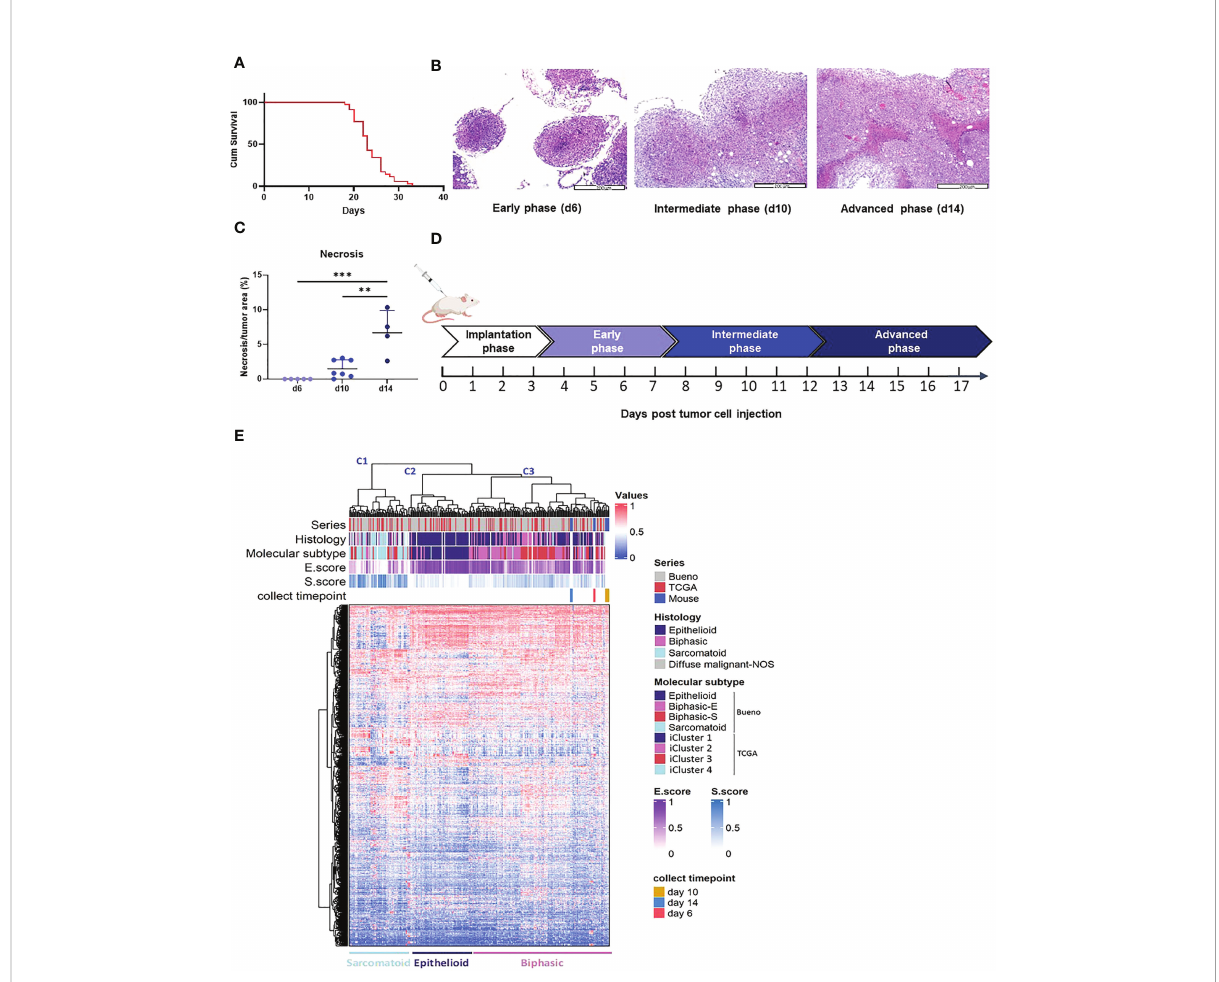
FIGURE 1 AB12 tumors characterization. (A) Kaplan-Meier survival curve of mice injected with AB12 cells. n=28. Cum: cumulative. (B) Histological features of early, intermediate and advanced phase AB12 tumors. Representative hematoxylin and eosin staining of tumors. Original magni fi cation X10. (C) Evaluation of the necrosis area in AB12 tumors. The percentage of necrotic area out of the entire tumor area in d6, d10 and d14 tumors is shown. Values of the post hoc Tukey test are indicated at the top of the dot plots. **: p ≤ 0.01; ***: p ≤ 0.001. (D) Schematic axis of tumor development. (E) Integration based on transcriptomic data of AB12 tumors in hMPM tumors. Unsupervised clustering of d6, d10 and d14 AB12 tumors with 295 hMPM tumor samples was performed based on transcriptomic data obtained by RNA-Seq. The series of each tumor sample, the histologic and molecular subtypes, the histo-molecular gradients (E.score and S.score) and the collect timepoint of AB12 tumors are indicated by a color code or a color gradient at the top of the heatmap. Clusters C1 to C3 are indicated at the top as well as the deduced histologic subtypes at the